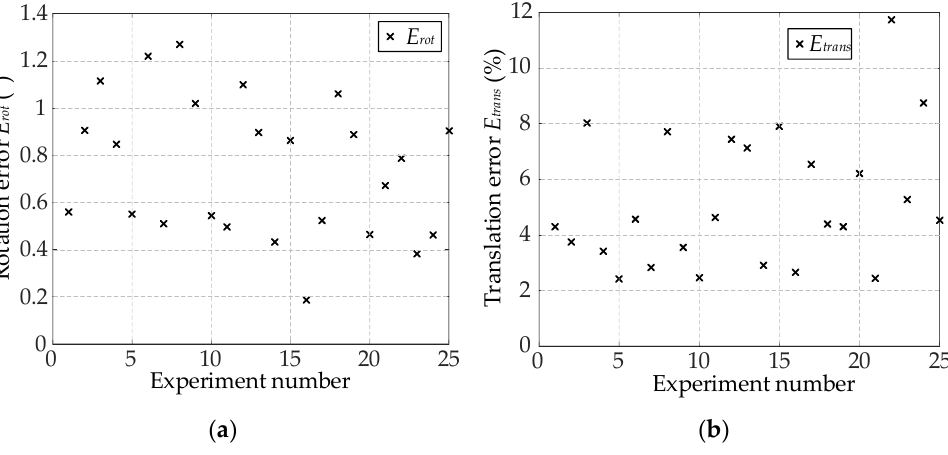
it can be seen that the rotation error was less than 1.3 ◦ . The general trend was that the rotation error decreased with a decrease in the distance between the camera and guidance along the z -axis. The translation error was less than 12%. lamps along the z -axis. The translation error was less than 12%.